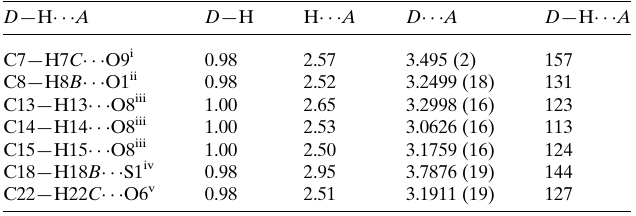
Table 2 Hydrogen-bond geometry (A˚ , (cid:3) ).